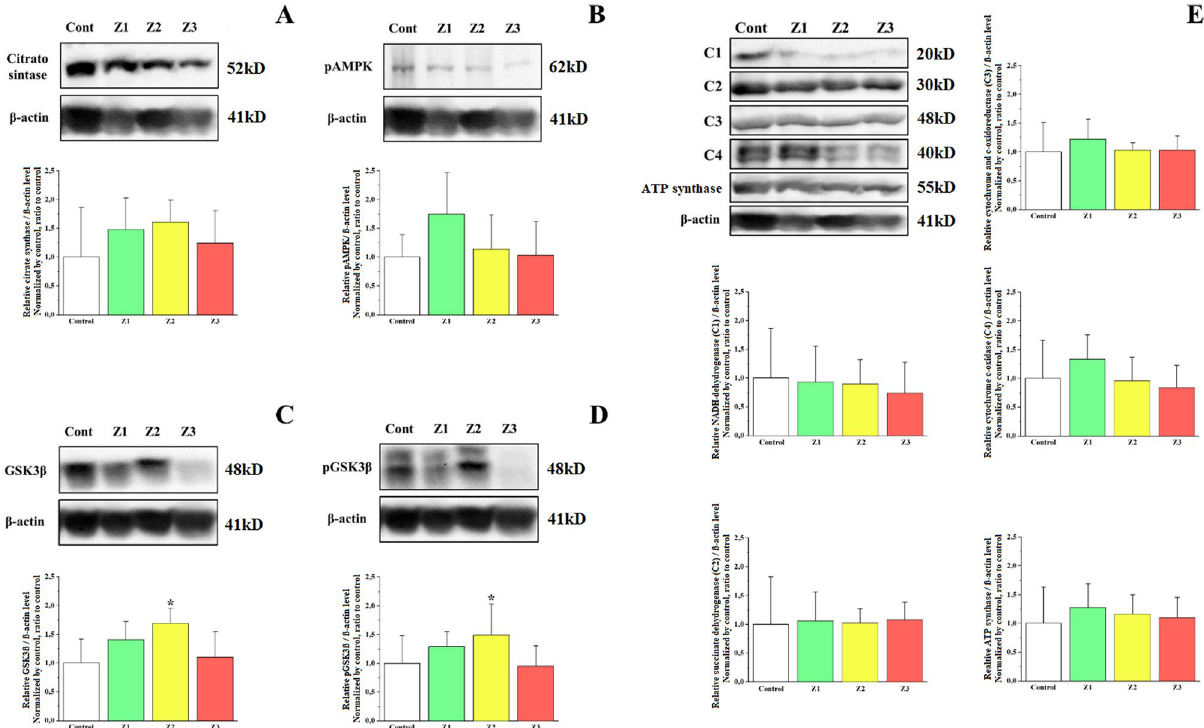
Figure 5. Protein content of CS ( A ), phosphorylated AMPK ( B ), GSK3β (total and phosphorylated protein ( C and D ), and oxidative phosphorylation complexes (OXPHOS; E) in the soleus muscle of the four experimental groups after five weeks of intervention. C1 = NADH-dehydrogenase; C2 = succinate dehydrogenase; C3 = cytochrome and c-oxidoreductase; C4 = cytochrome c-oxidase; Cont = control group; Z1 = low intensity training group; Z2 = moderate intensity training group; Z3 = high intensity training group; * = statistically significant difference for the control